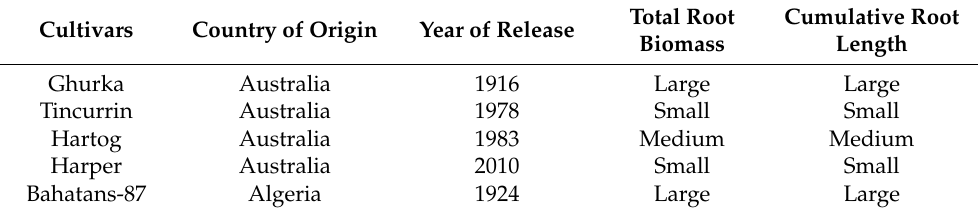
Table 1. Five wheat cultivars with the country of origin, year of release and apparent root biomass and cumulative root length at the onset of tillering (Z2.1) identified in a phenotyping study using a semi-hydroponic system. Supplementary data from a previous semi-hydroponic phenotyping study are available in Table